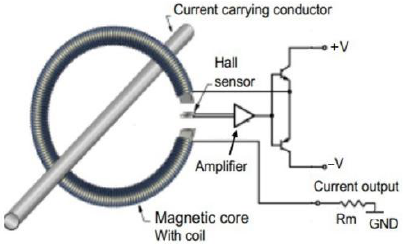
Figure 1. Schematic diagram of magnetic balance current sensor.